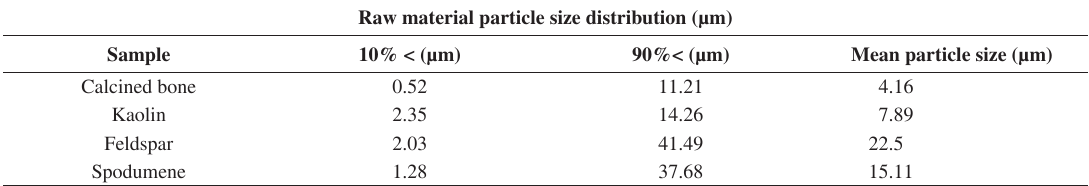
Table 2. Raw materials particle size distribution. After wet